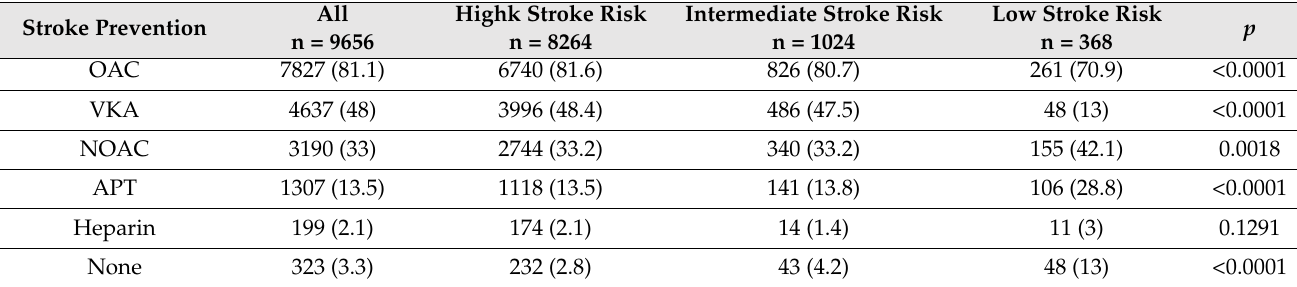
Table 2. Stroke prevention according to stoke risk in the study group.